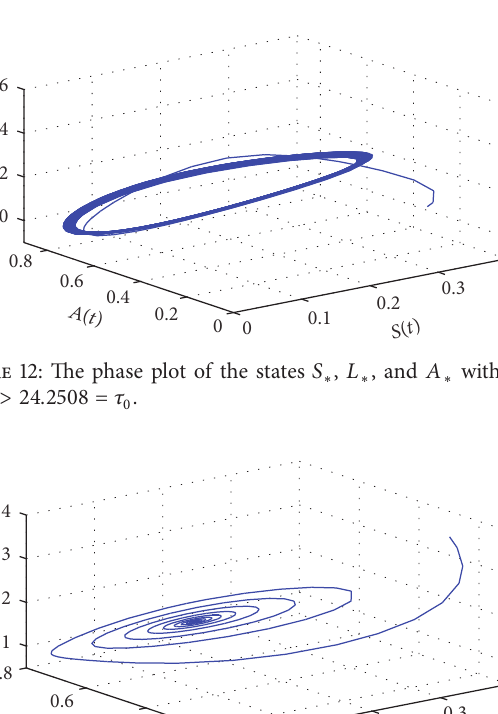
Figure 11: The phase plot of states 𝑆 ∗ , 𝐴 ∗ , and 𝑅 ∗ with 𝜏 = 25.47 > 24.2508 = 𝜏 0 .